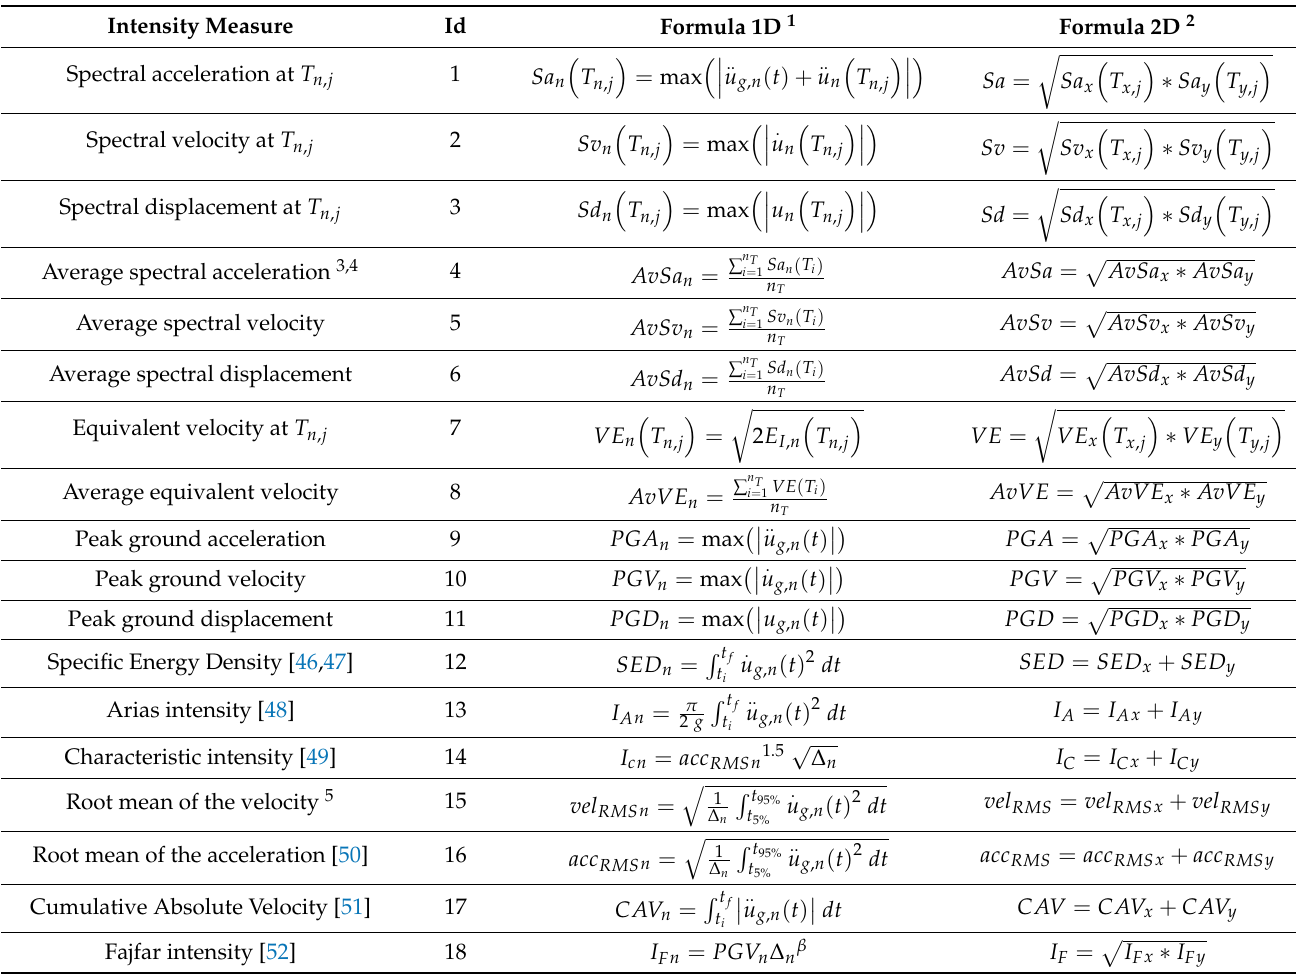
Table 2. Intensity measures